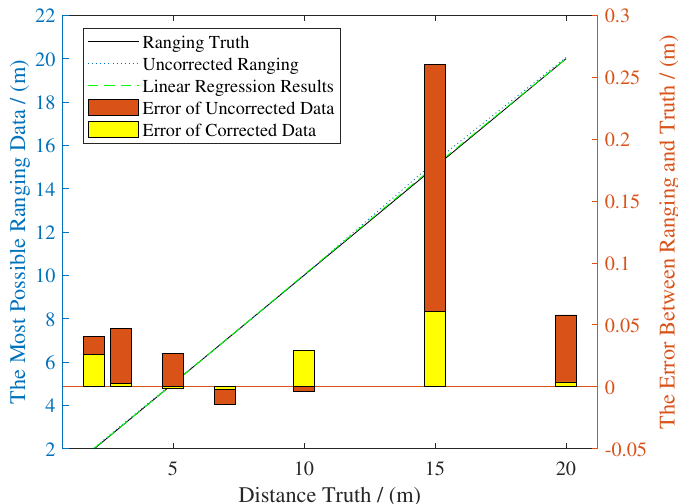
Figure 8. Comparison shows linear regression improves the accuracy of ranging, with error limited in 0.05